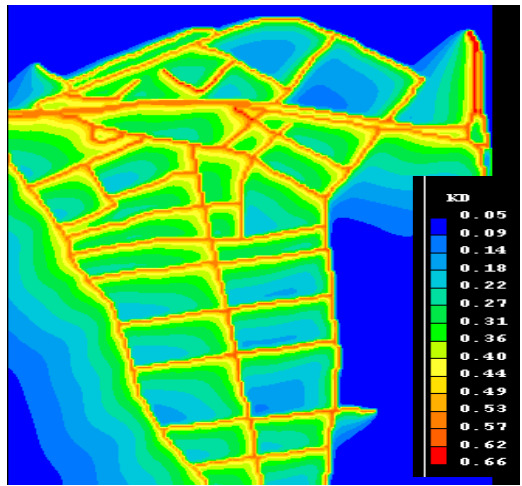
Fig. 2. Results of SP concentration dispersion on April 26, 2005 (during “rush” hours) in Žvėrynas district area